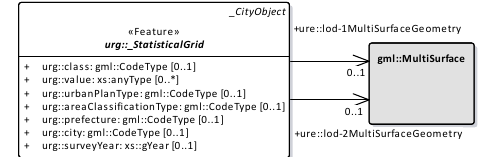
Figure 8. UML class diagram of the Extended LOD